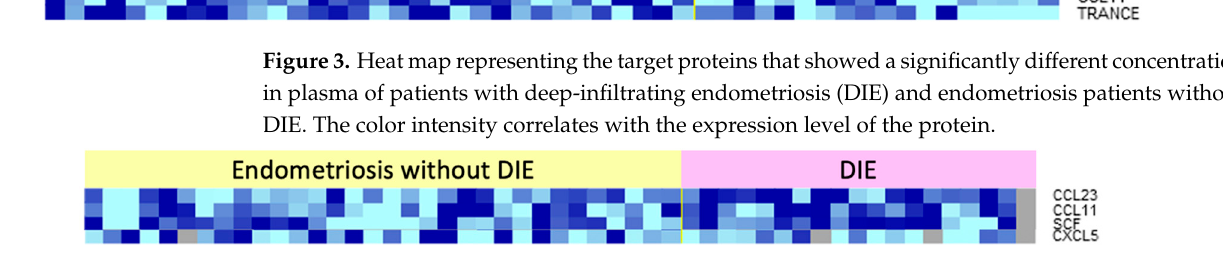
Figure 4. Heat map representing the target proteins that showed a significantly different concentration in PF of patients with deep-infiltrating endometriosis (DIE) and endometriosis patients without DIE. The color intensity correlates with the expression level of the protein.